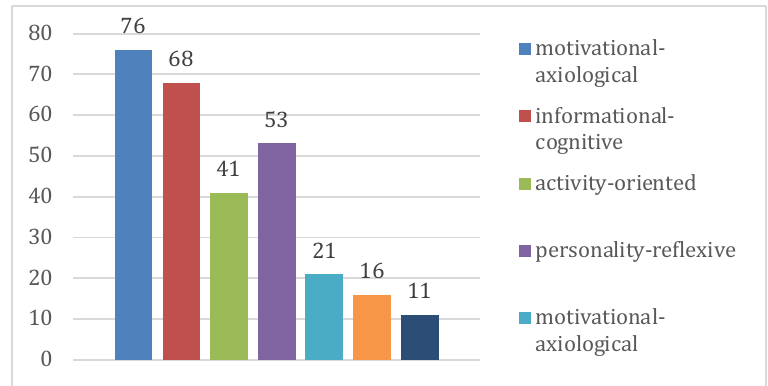
Fig. 2. The results of the final questionnaire aimed at the determination of the structural elements of the readiness of architecture students to conduct professional